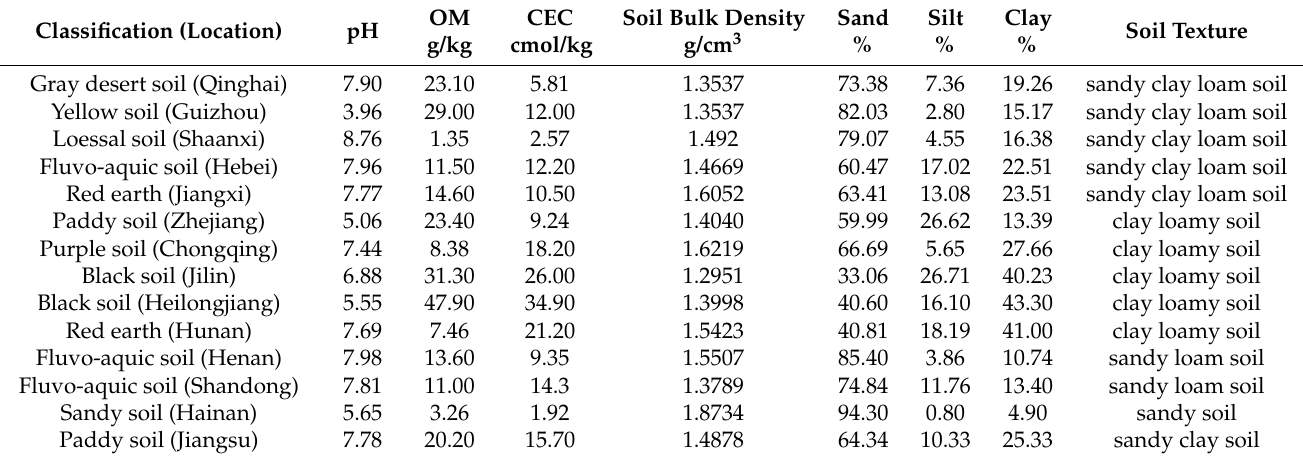
Table 1. Physiochemical properties of fourteen types of